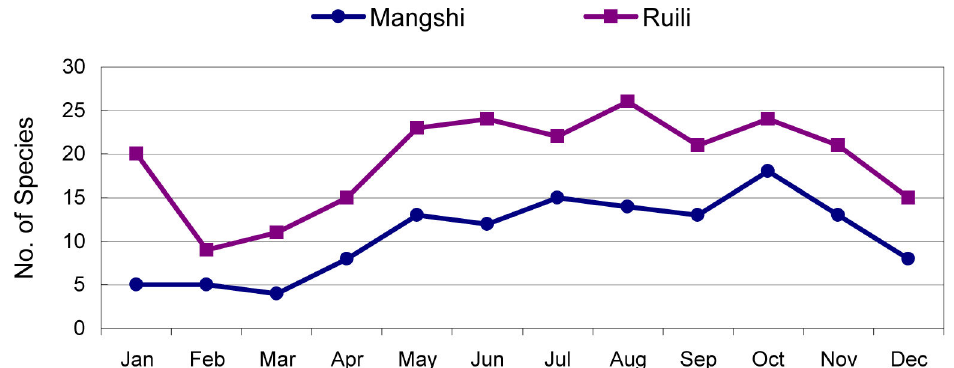
Figure 2. Comparison of species richness (the number of species) between Manshi and Ruili for each month , 2010.